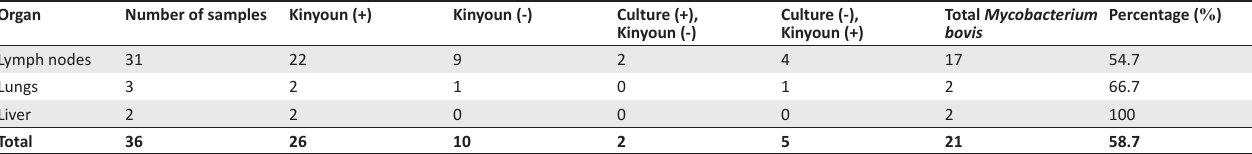
TABLE 5: Summary of results of Kinyoun staining versus culture. Organ Number of samples Kinyoun